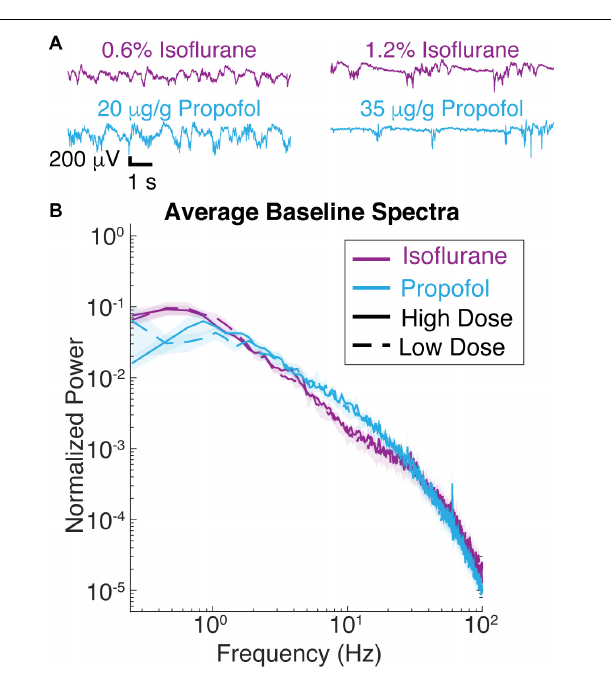
FIGURE 2 | Spontaneous LFP of mice under isoflurane and propofol have similar spectral characteristics. (A) Ten seconds of unstimulated local field potential (LFP) recorded in V1 under high dose isoflurane (1.2%), low dose isoflurane (0.6%), high dose propofol (35 µ g/g brain), low dose propofol (20 µ g/g brain). (B) Power spectra of 1 min of unstimulated LFP from V1 were computed for all seven animals. Blue curves are from animals under propofol, while purple traces are from animals under isoflurane. Solid lines denote high drug concentrations while dashed denote low drug concentrations. Shading represents the 95% confidence intervals for each